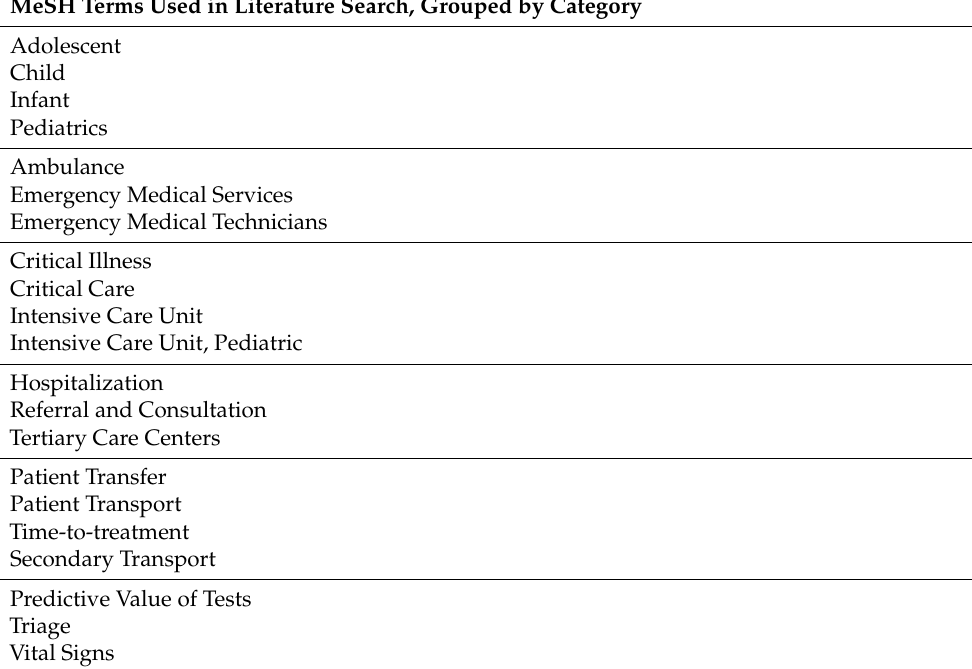
Table 1. Medical Subject Heading (MeSH) Terms used in PDTree Literature